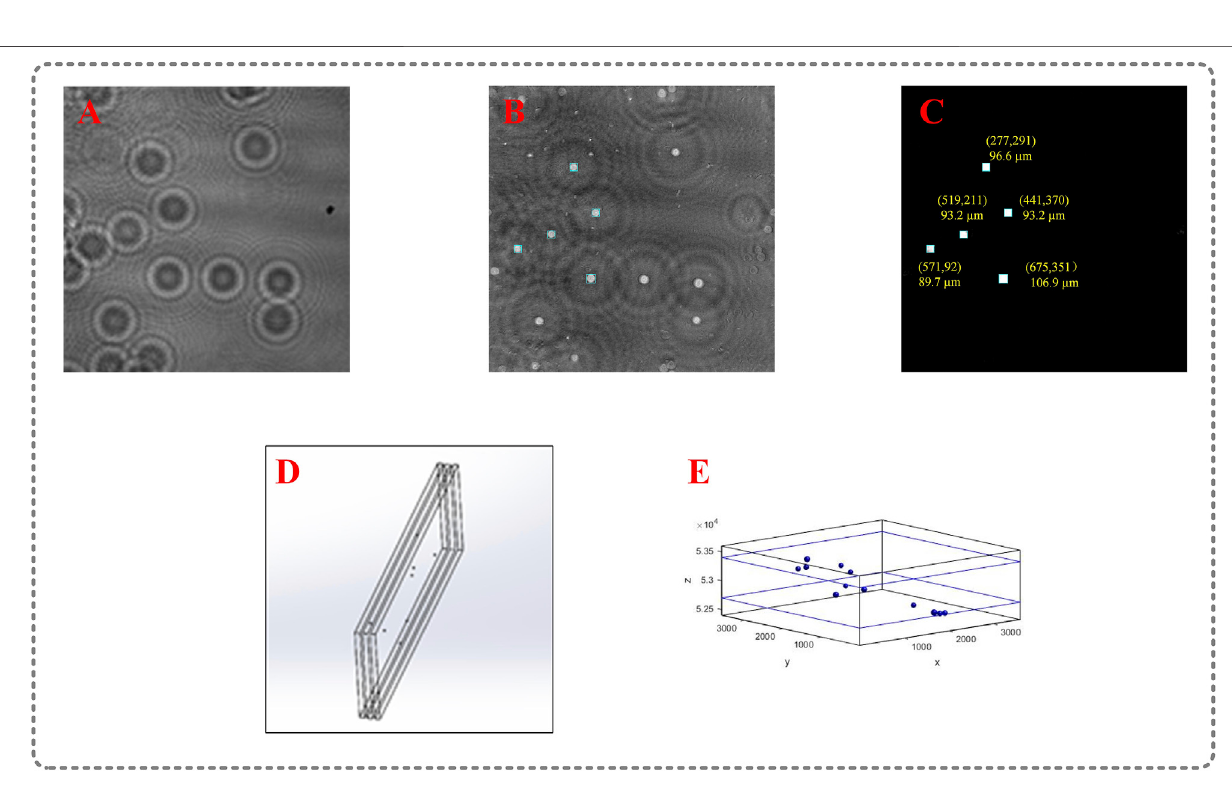
Frontiers in Physics |